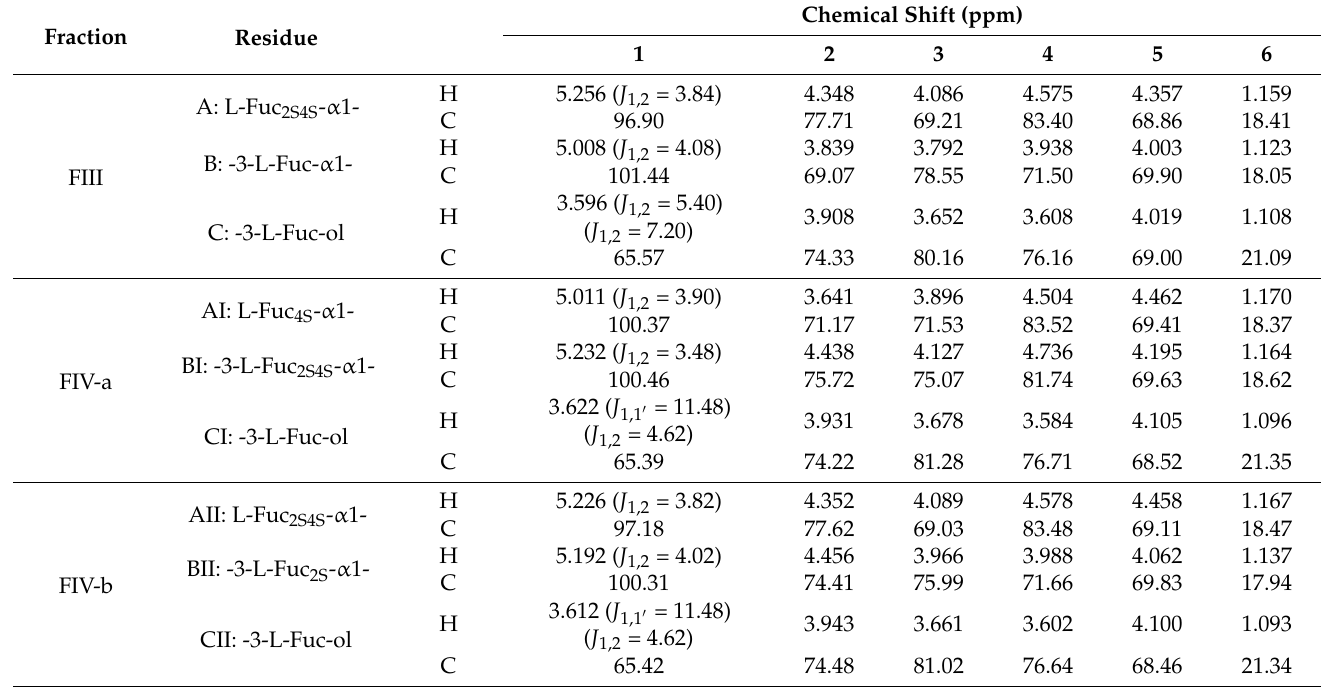
Table 2. 1 H and 13 C chemical shifts of the oligosaccharide FIII and FIV.